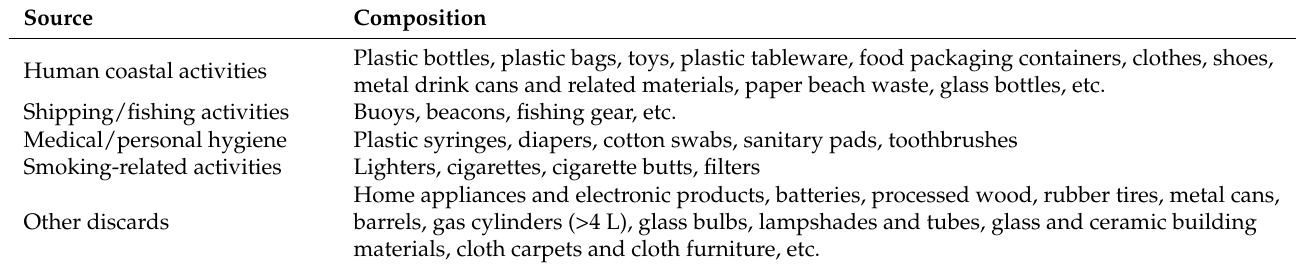
Table 1. Classification of beach waste